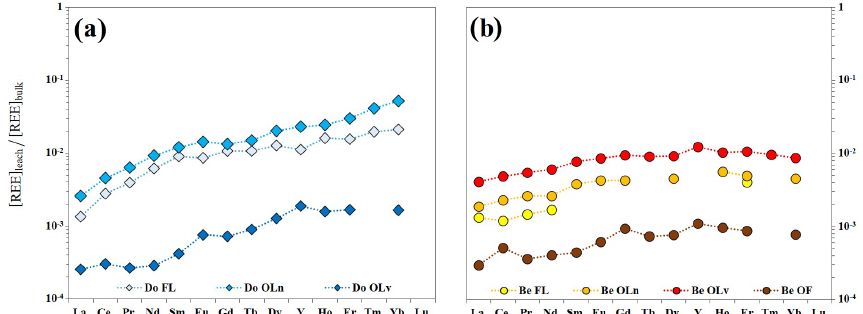
Figure 4. Patterns of REE in leachates normalized to the REE concentrations in leaves and litter for Douglas-fir (a) and beech (b)